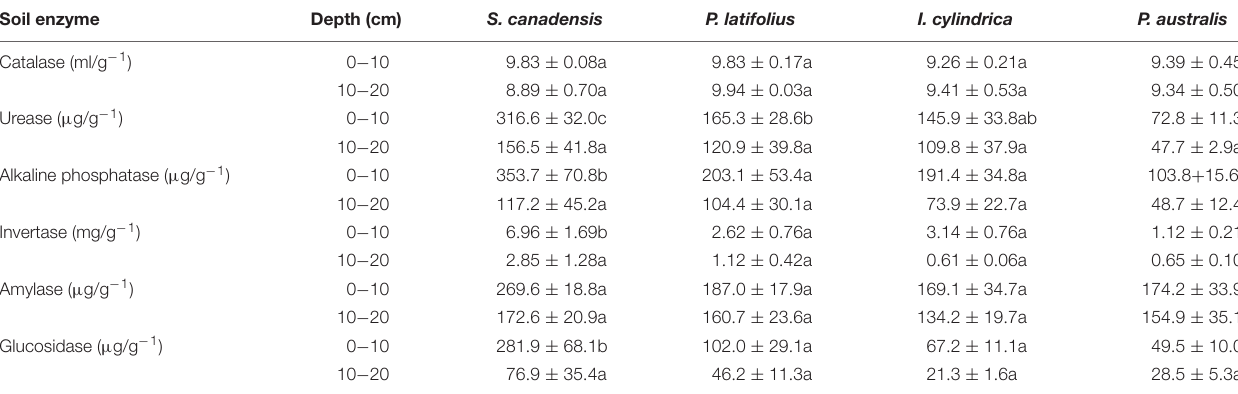
Data are means ± SE. Within the same row, means sharing the same letters are not different at P = 0.05 (by Tukey test).